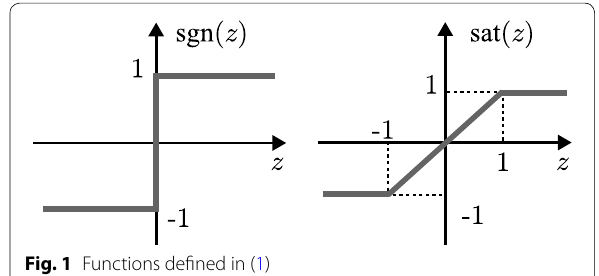
Fig. 1 Functions defined in